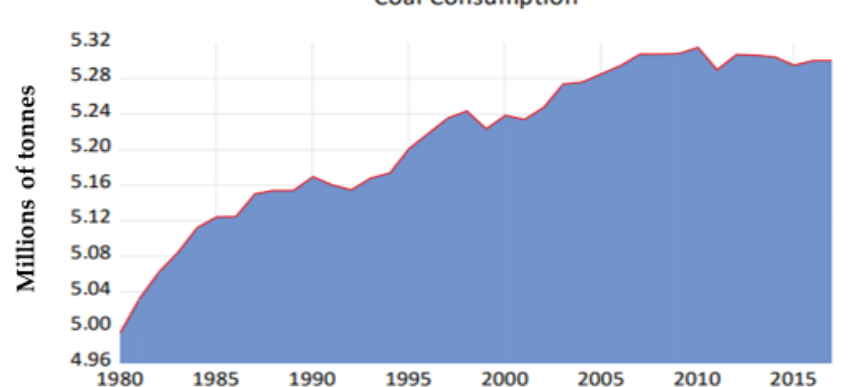
Figure 1. Coal Consumption in SA from 1980 to 2015. Table 1. Acronyms of the PAHs investigated in this study. Polycyclic Aromatic Hydrocarbons